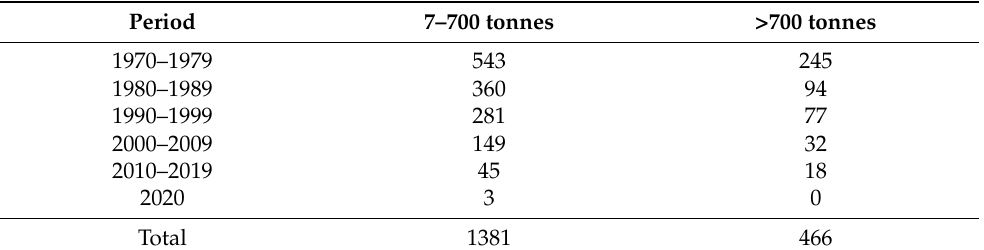
Table 1. Number of medium (7–700 tonnes) and large (>700 tonnes) spills per decade from 1970